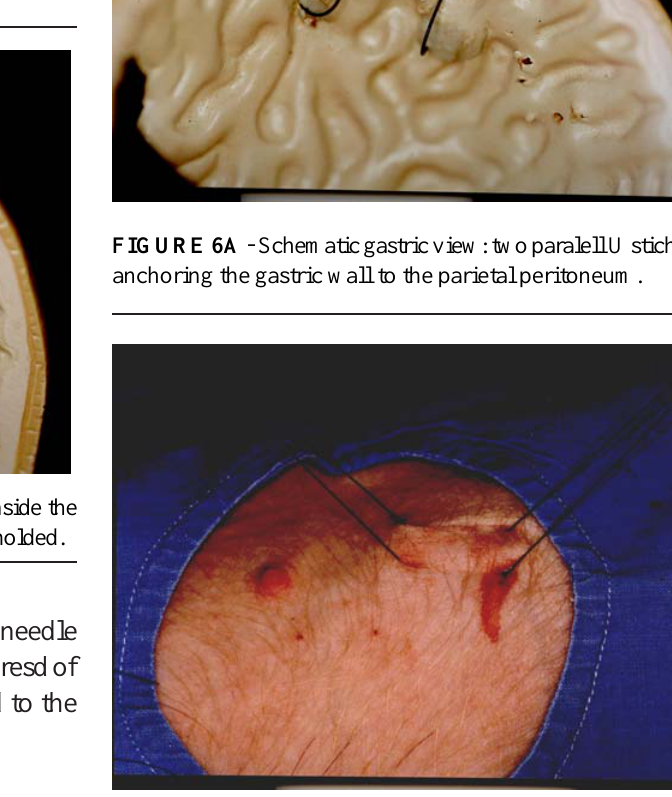
FIGURE 3 - The parallel puncture of spinal needle is done and passed through the loop before forming.